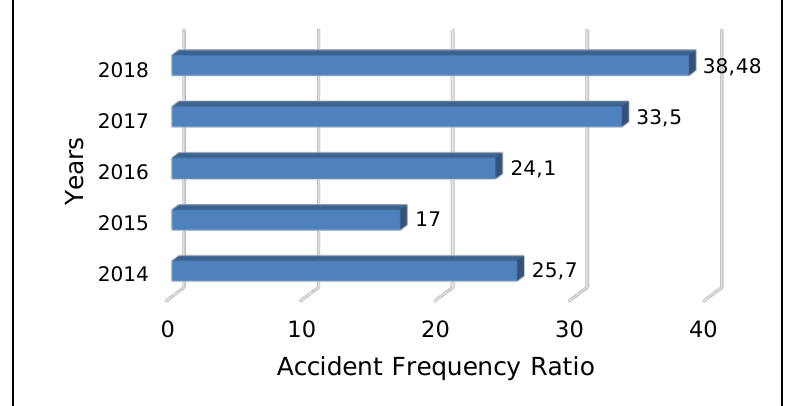
Figure 2. Accident Frequency Ratio for the Years 2014 and